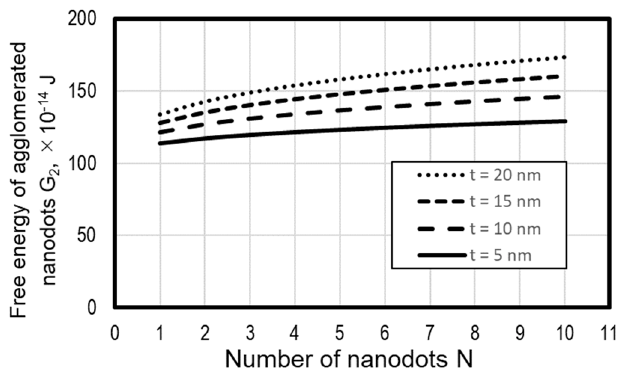
Figure 9. Variation of free energy of separated dots against the number of dots in a square grid.